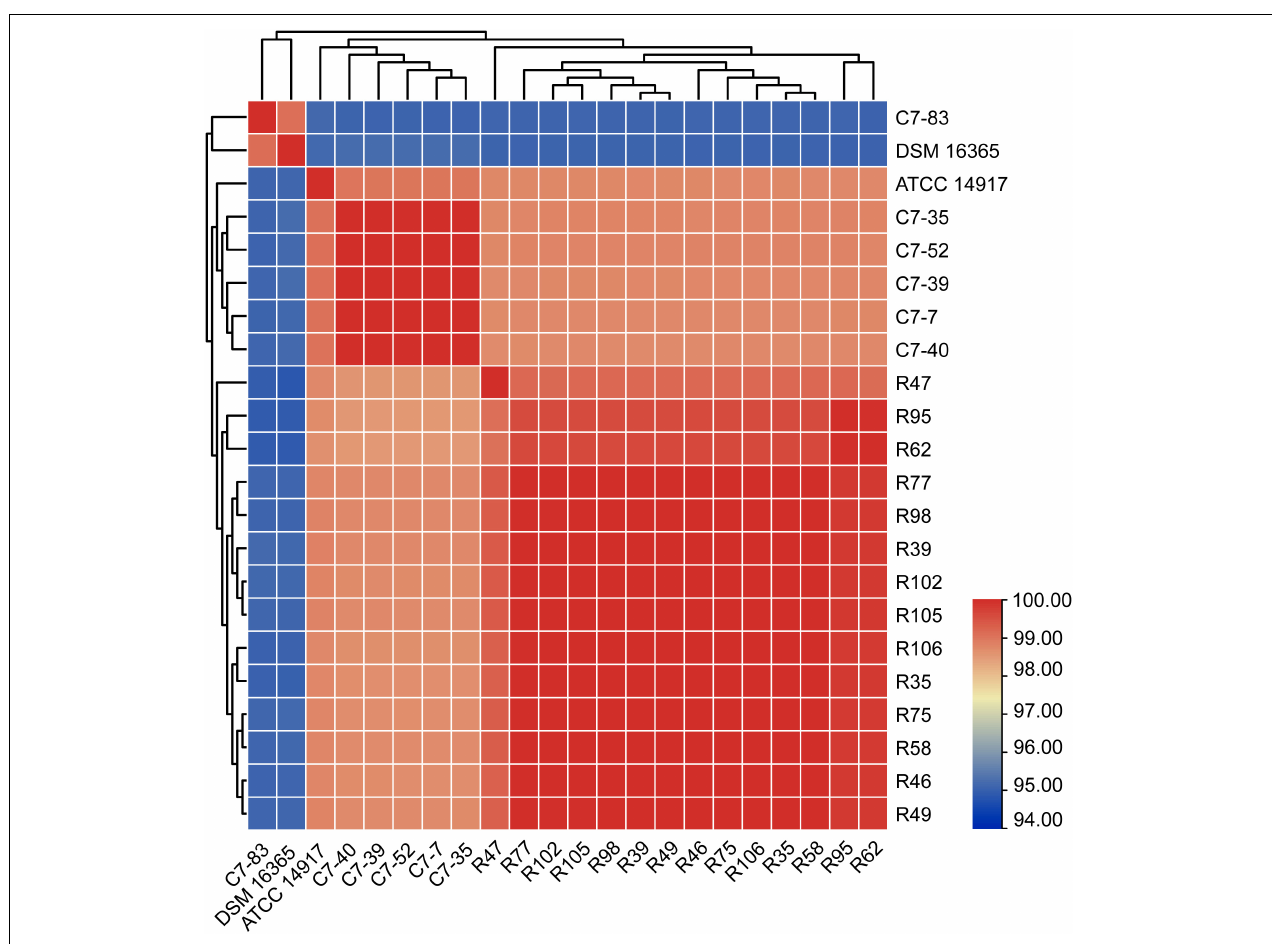
FIGURE 3 | Heatmap of the interspecies genomic similarity based on the % ANI of 20 Lactiplantibacillus isolates and two reference strains, L. argentoratensis DSM 16365 and L. plantarum ATCC 14817. The bar on the right represents the color codes for ANI values from pairwise comparisons of